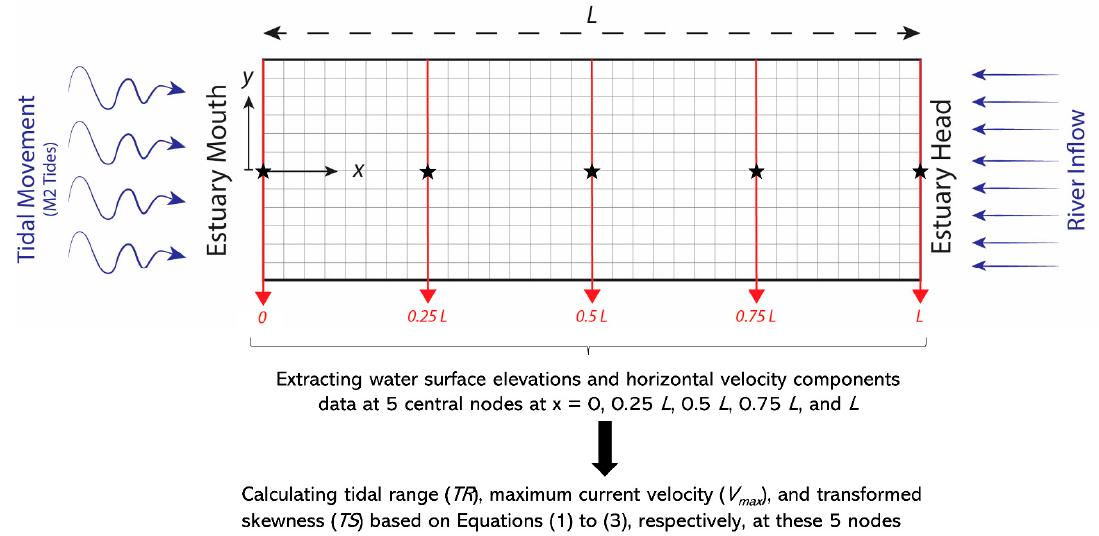
Figure 2. An example of a gridded prismatic estuary together with five different locations at x = 0, 0.25 L , 0.5 L , 0.75 L , and L , where data of water surface elevations and horizontal velocity components were extracted to calculate tidal range, maximum current velocity, and transformed skewness. Star symbols show the nodes where the flow data were extracted and examined.